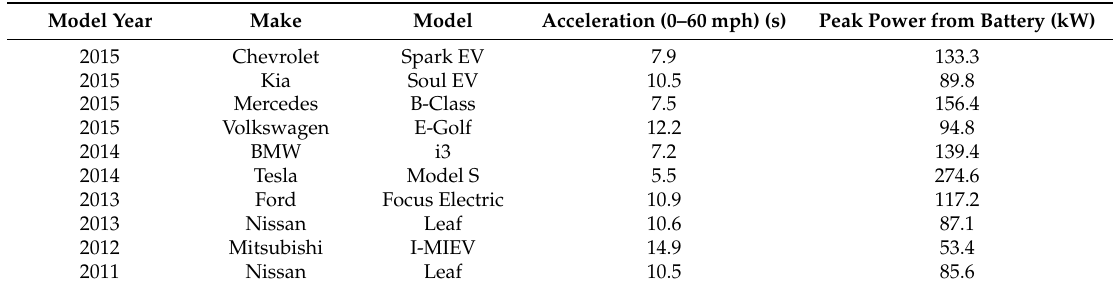
Table A2. Vehicle data for acceleration time vs. peak battery power (Figure